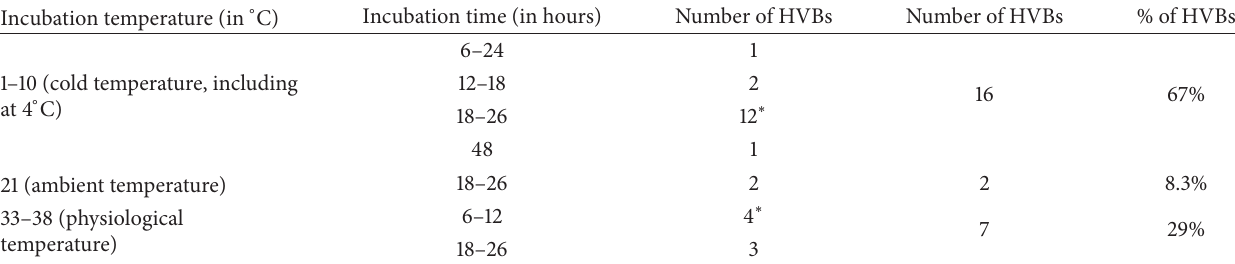
Table 6: Incubation temperatures and durations used for decontamination of